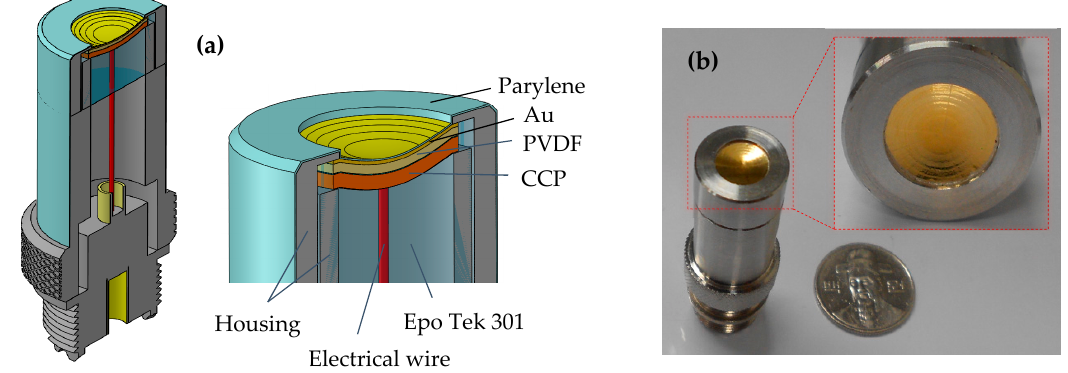
Figure 5. ( a ) A cross-sectional view of MFP transducer. ( b ) Photograph of the fabricated MFP transducer for long depth ultrasound images.